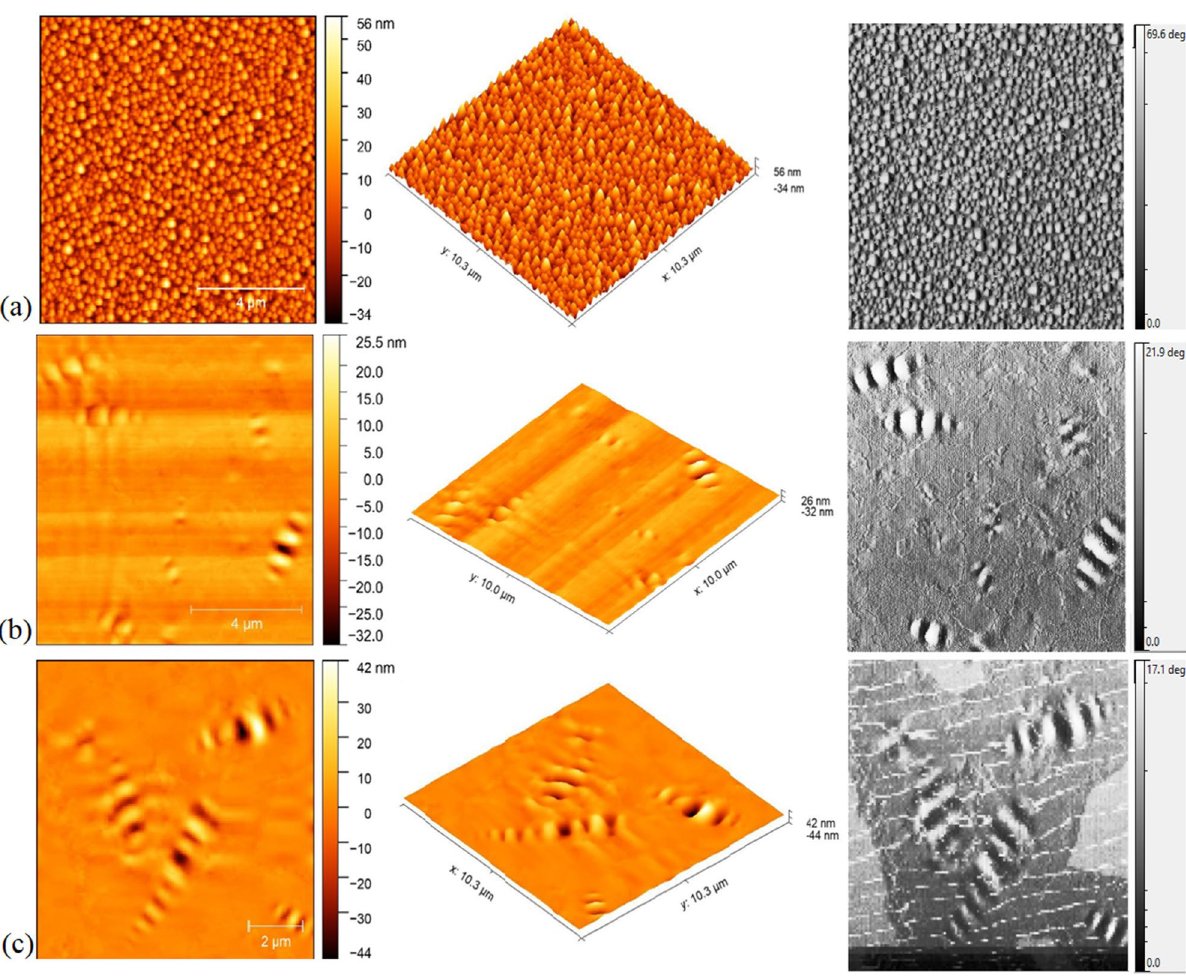
Figure 9. AFM morphology images of asphalt binder: ( a ) unaged, ( b ) short-term aged, and ( c ) long-term aged; at three different modes: right row) 2D topography, center row) 3D view of the surface, and left row) phase